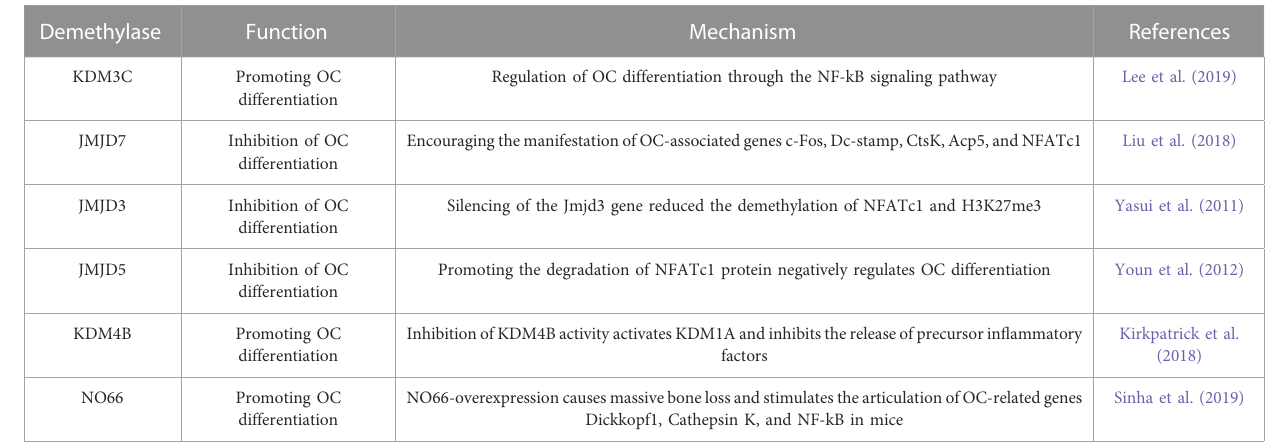
TABLE 2 Histone demethylase and OC